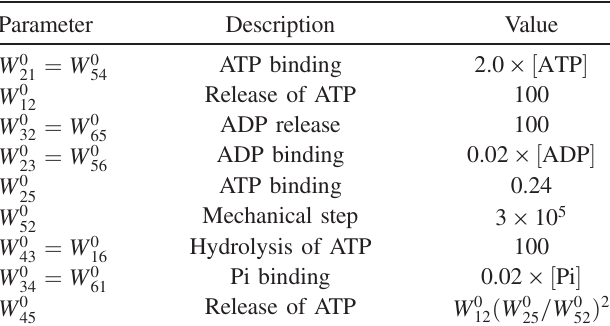
TABLE II. Transition rates for the chemomechanical cycle for the kinesin model in Fig. 10 [79]. All the rate constants W ij (except W 21 , W 23 , W 34 , W 54 , W 56 , and W 61 , which are in units of s − 1 μ M − 1 ) are given in units of s − 1 , and the concentrations in μ M. Parameter